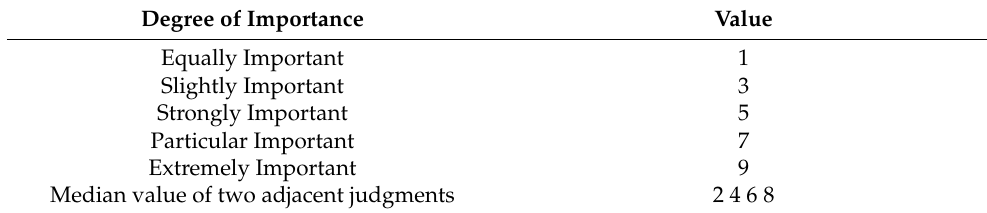
Table 2. Importance scale. Degree of Importance Value Equally Important